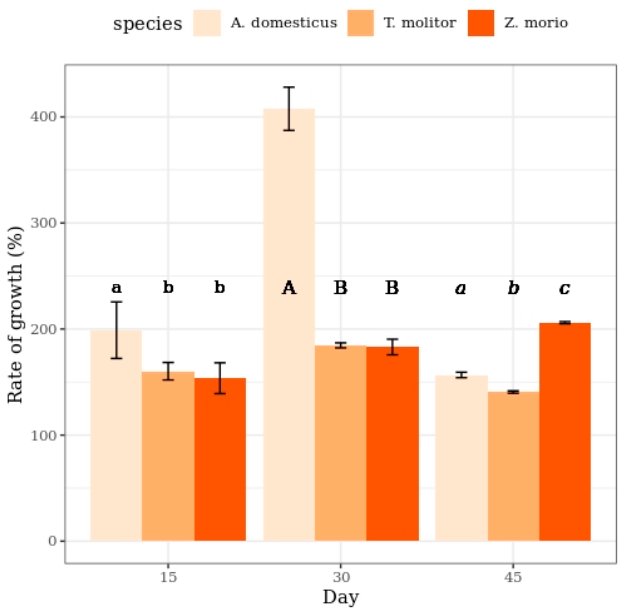
Figure 3. Rate growth of T. molitor and Z. morio larvae and A. domesticus when reared on the different substrates (the bars indicate the 95% confidence interval). Different letters show statistically significant differences among the species.